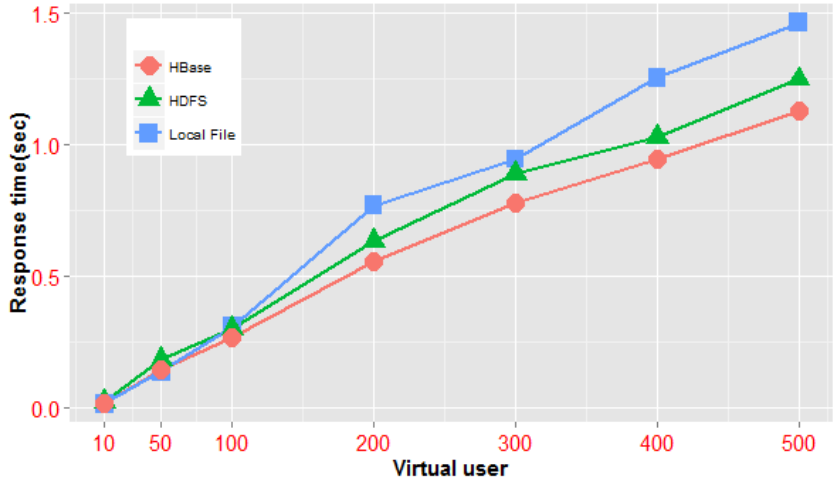
Figure 17. Response time of a rectangle-range query in the same level.